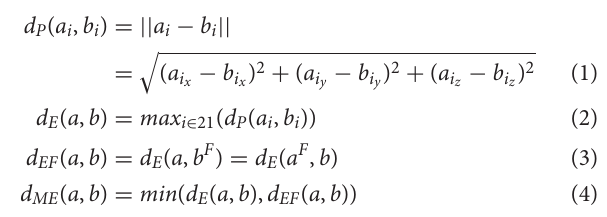
it is not possible to have a unique valid orientation for all